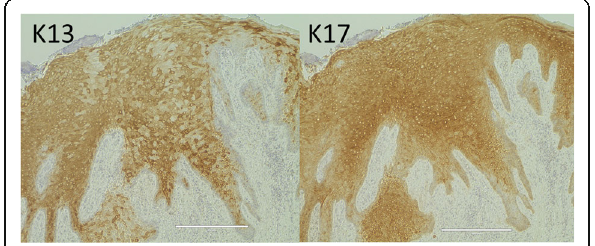
Fig. 4 Immunohistological findings show a negative staining mosaic pattern for keratin 13 (k13) and positive staining for keratin 17 (k17) (immunohistological staining, bar 400 μ